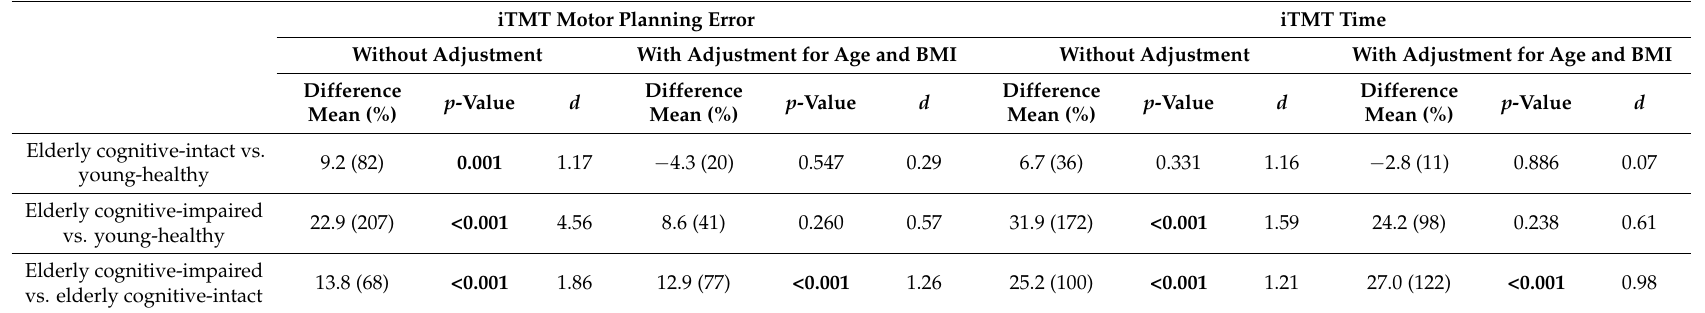
Table 3. Between-group comparison of iTMT motor planning error and iTMT time with and without adjustment for age and BMI iTMT Motor Planning Error iTMT Time Without Adjustment With Adjustment for Age and BMI Without Adjustment With Adjustment for Age and BMI Difference p -Value Mean (%)